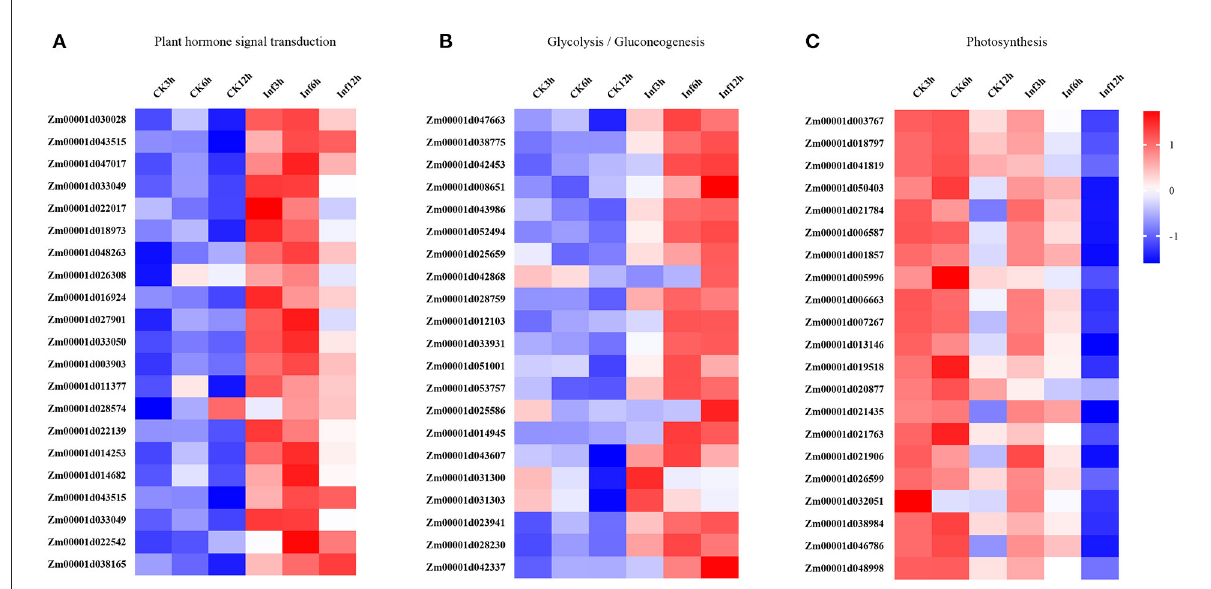
FIGURE5 Changes in the expression levels of DEGs 3, 6, and 12h, respectively after Ustilago maydis inoculation associated with KEGG pathways. Different colors represent differences in gene expression between CK and Inf samples (upregulated, red; downregulated, blue; mean, white). (A)